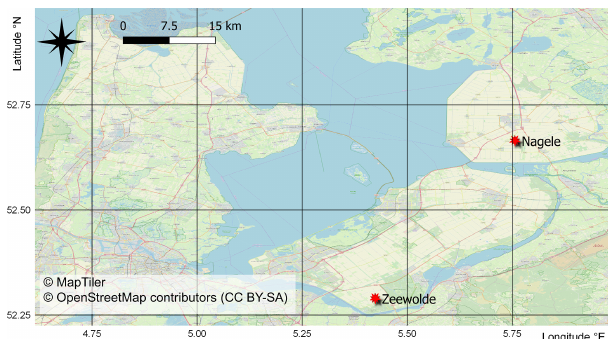
Figure 1. Locations of the Zeewolde and Nagele sites in the Tiler and © OpenStreetMap contributors 2020. Distributed under a Creative Commons BY-SA